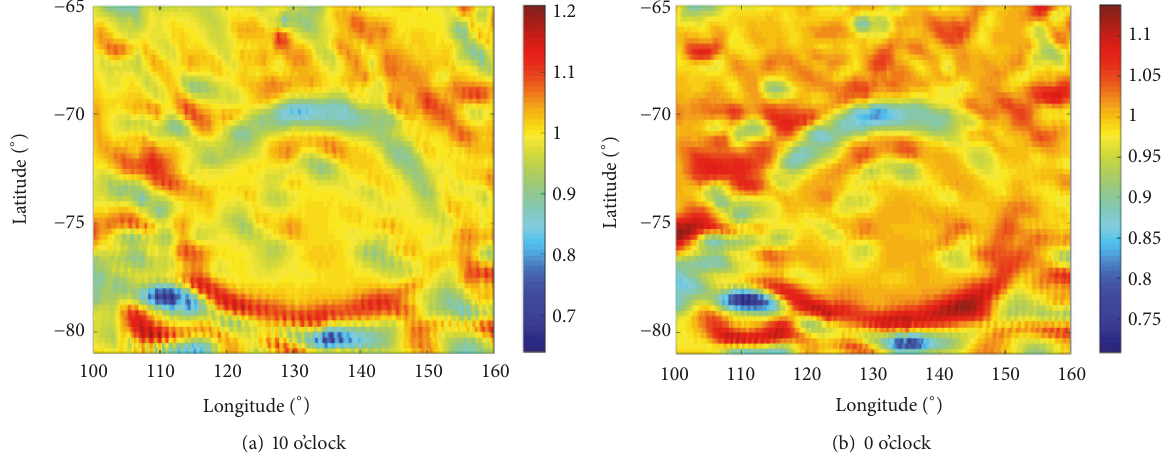
Figure 6: n T map of Schr¨odinger basin at 37 GHz. B